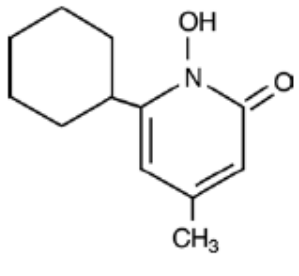
FIGURE 7. The chemical structure of